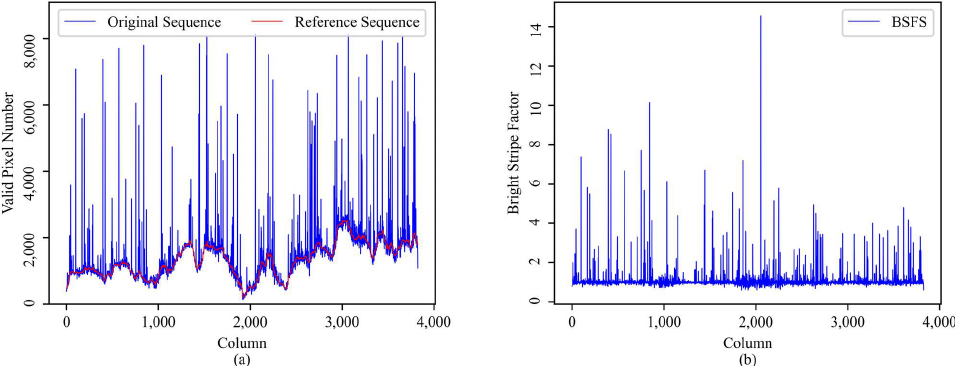
Figure 5. The bright stripe detection of the image shown in Figure 3a. ( a ) The valid pixel number sequence; ( b ) the bright stripe factor sequence.